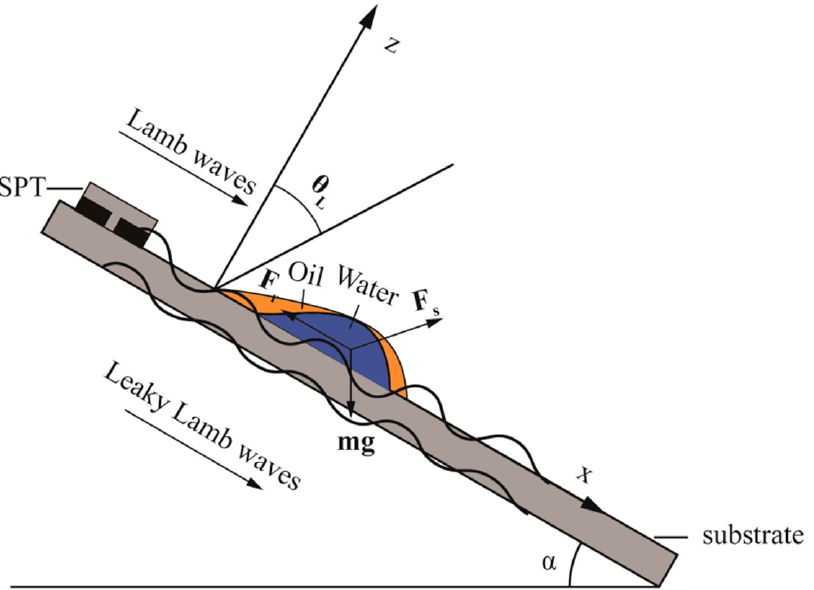
Figure 1. Schematic diagram of an oil/water mixed drop that is produced by a 10 μ L olive oil drop and a 10 μ L water drop of the motion on an inclined substrate. theory, and the equation was given by